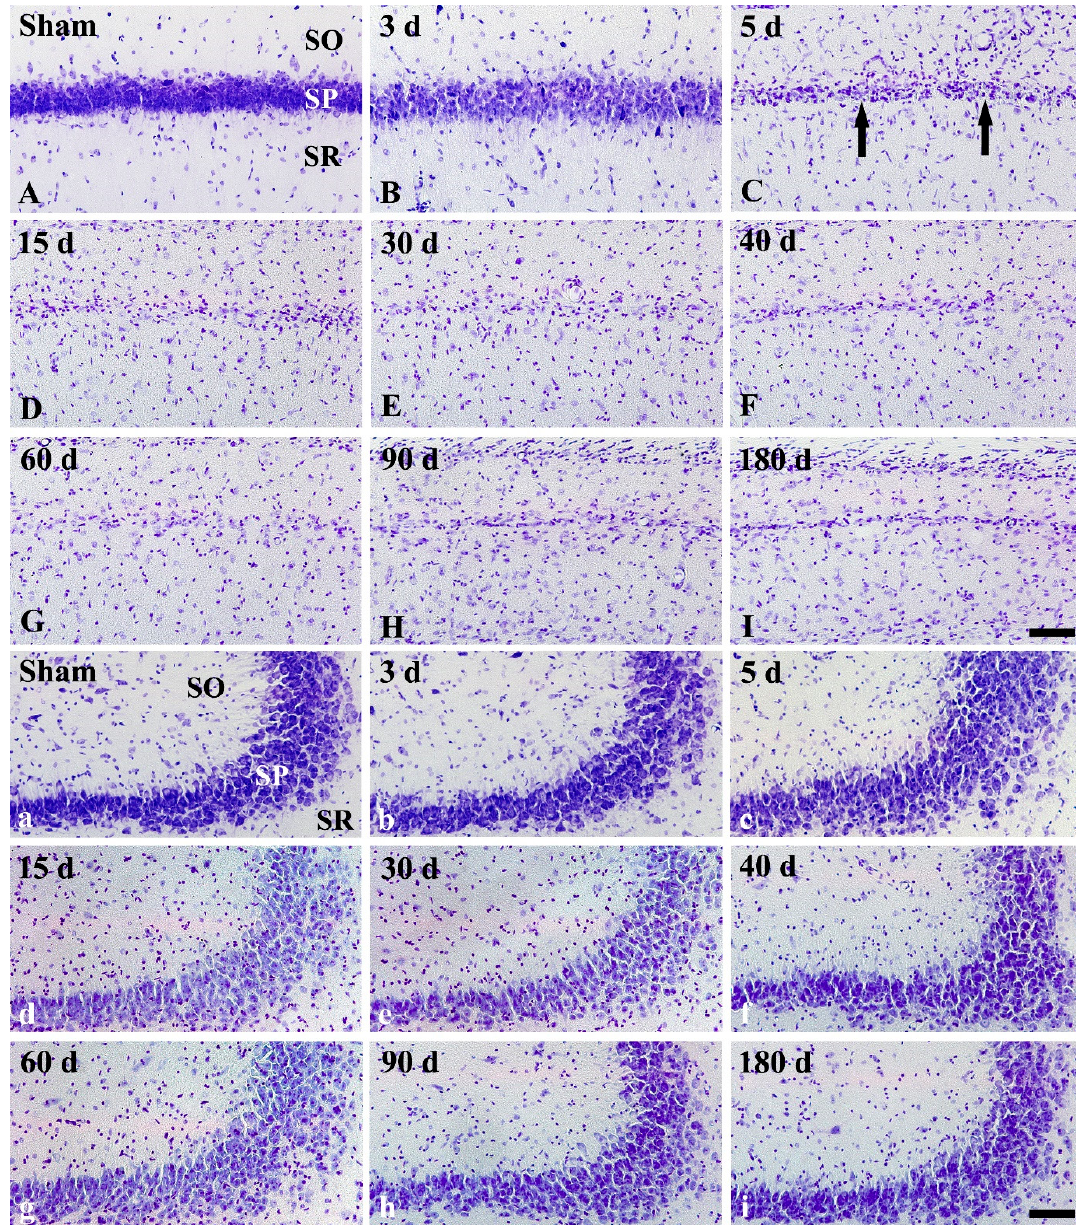
Figure 2. High magnification of CV staining of CA1 ( A – I ) and CA2/3 ( a – i ) of the sham operated ( A , a ) and ischemia operated ( B – I , b – i ) groups after tgCI. In the CA1, CV stained cells were hardly shown in the stratum pyramidale (SP, arrows) from 5 days after tgCI. In the CA2/3, CV + cells in the SP are slightly pale from 15 days after tgCI compared to those in the sham operated group. SO, stratum oriens; SR, stratum radiatum. Scale bar = 50 µm.